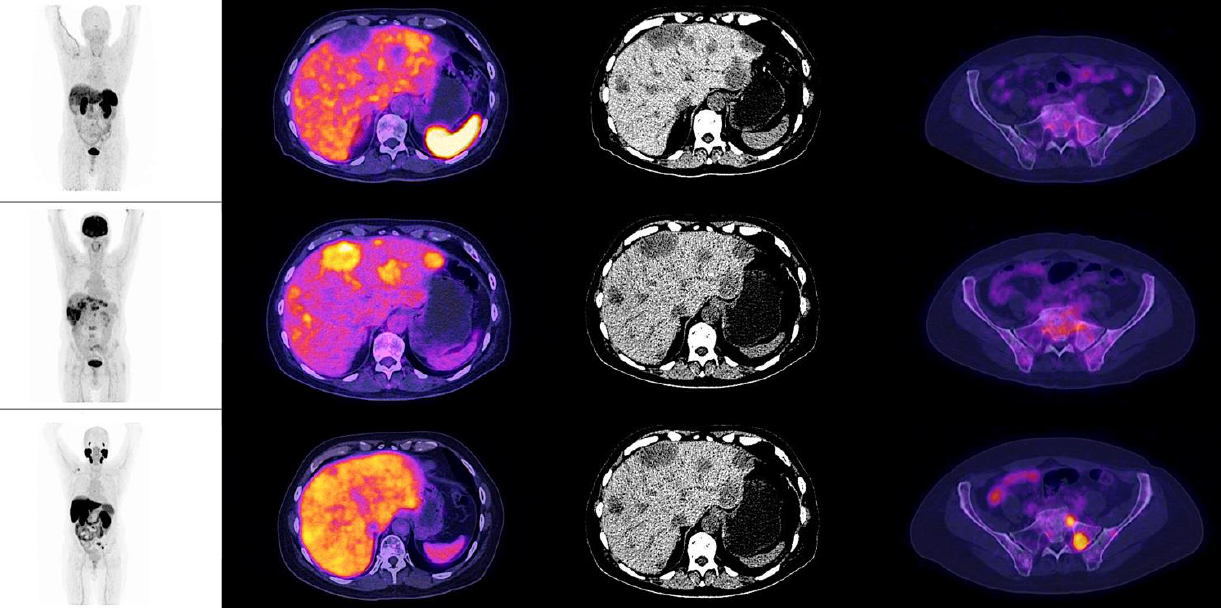
Figure 4. Patient number 7, a 67-year-old male, with an initial histopathological report of prostate adenocarcinoma, Gleason score 8 (4 + 4). Treated with androgen deprivation therapy + chemotherapy. Site of second biopsy was in a liver lesion, with a confirmatory histopathological report of neuroen- docrine carcinoma (positive immunohistochemistry for chromogranin and synaptophysin). Time lapse to neuroendocrine differentiation (NED) was 48 months, with a PSA value of 19.8 ng/dL at the time of diagnosis. The image shows the maximum intensity projection of the three radiotracers ( 18 F AlF-NOTA-Octreotide, 18 F–FDG and 18 F–PSMA-1007) with multiple hepatic lesions and focal uptake of 18 F-FDG PET/CT; PSMA and somatostatin analogues didn’t evidentiate radiotracer uptake. The image also displays bone metastases in left iliac bone and sacrum, both PSMA